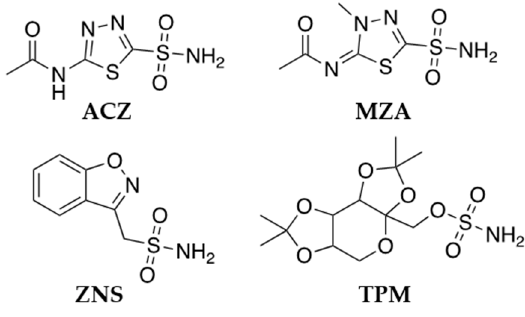
Figure 8. Chemical structure of the most known CA inhibitors.